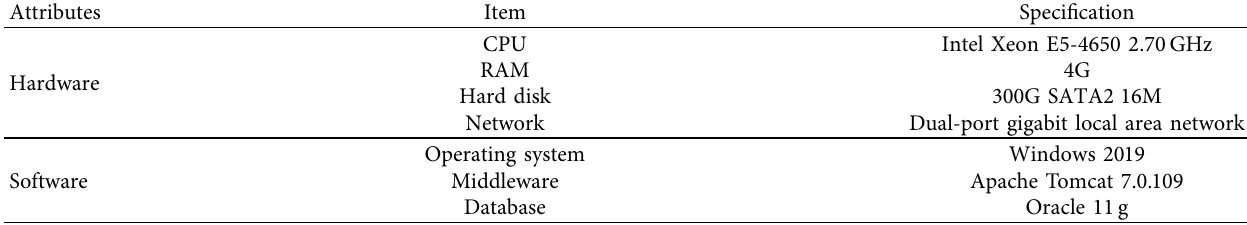
Table 4: Safety monitoring system test